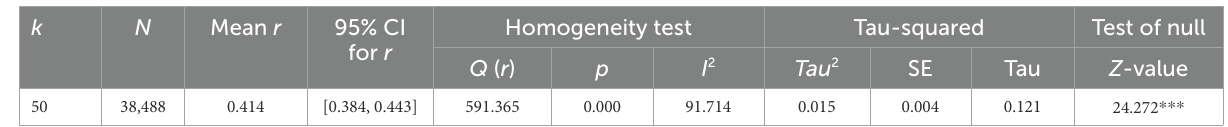
TABLE 2 Random model of the correlation between AB and